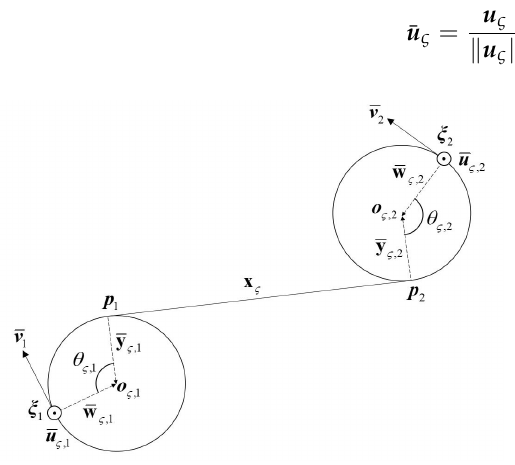
Figure 2. Geometry of the Dubins path connecting two waypoints of ξ